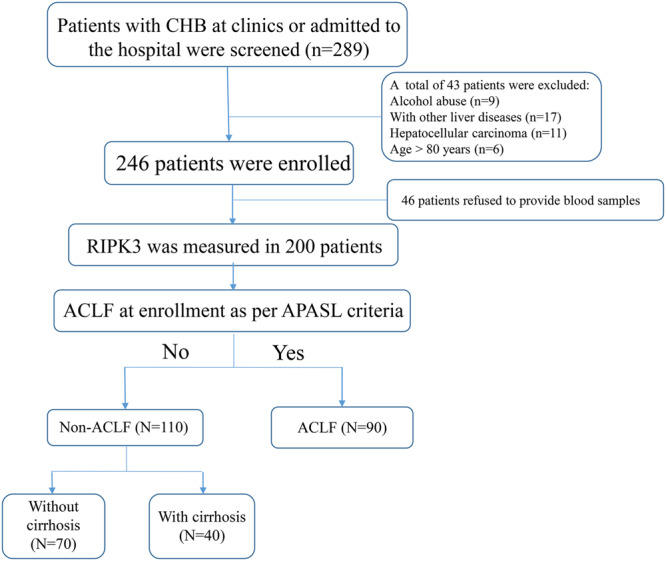
Flow chart of HBV-related patients in the present study.